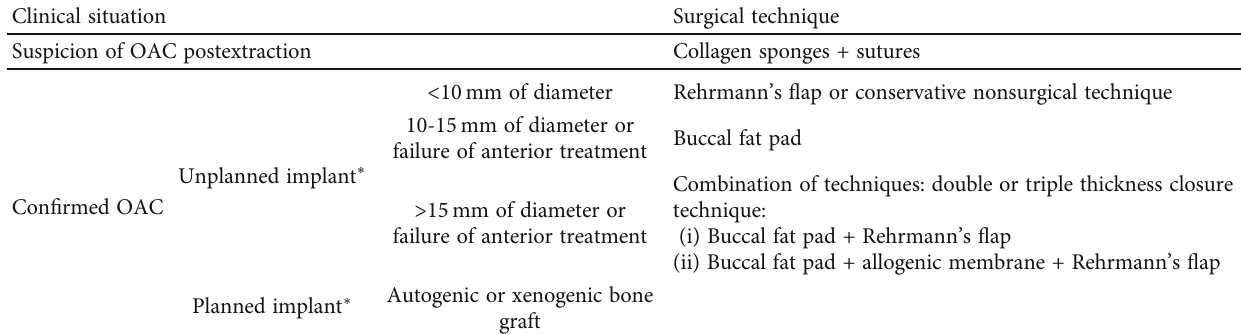
Table 1: Recommendations for the choice of surgical techniques according to the clinical situation. Clinical